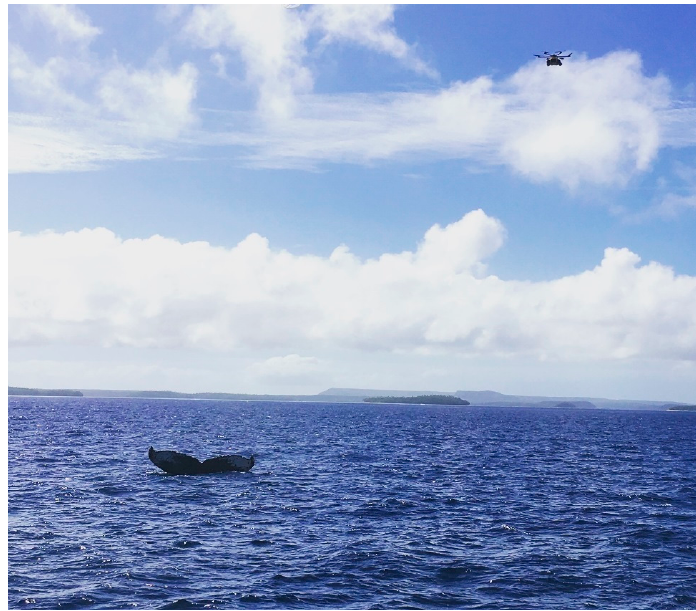
Figure 4. HexH2O™ has been used to observe the behavior of humpback whales in their Tongan breeding ground around the Vava’u archipelago [54].